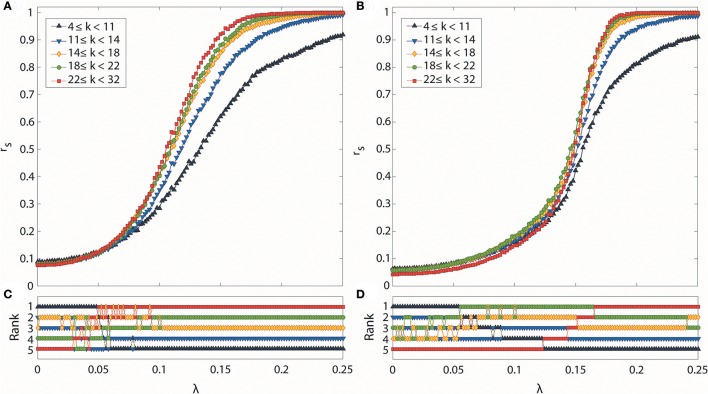
Synchronization level and synchronization rank for subgroups classified according to degree. Global synchronization monitored by median Dij for all nodes i of each subgroup in (A) progressive and (B) abrupt transitions. Each colored line indicates a synchronization level of each subgroup classified with node degree k (black: 4 ≤ k < 11, blue: 11 ≤ k < 14, yellow: 14 ≤ k < 18, green: 18 ≤ k < 22, and red: 22 ≤ k < 32). Synchronization rank among subgroups in (C) progressive and (D) abrupt transitions. Each color is the same as denoted in (A,B). In the progressive transition, subgroups with a higher degree are synchronized earlier. In the abrupt transition, the synchronization of hub nodes is suppressed below a certain value λ, but sharply increases after the critical point is reached.